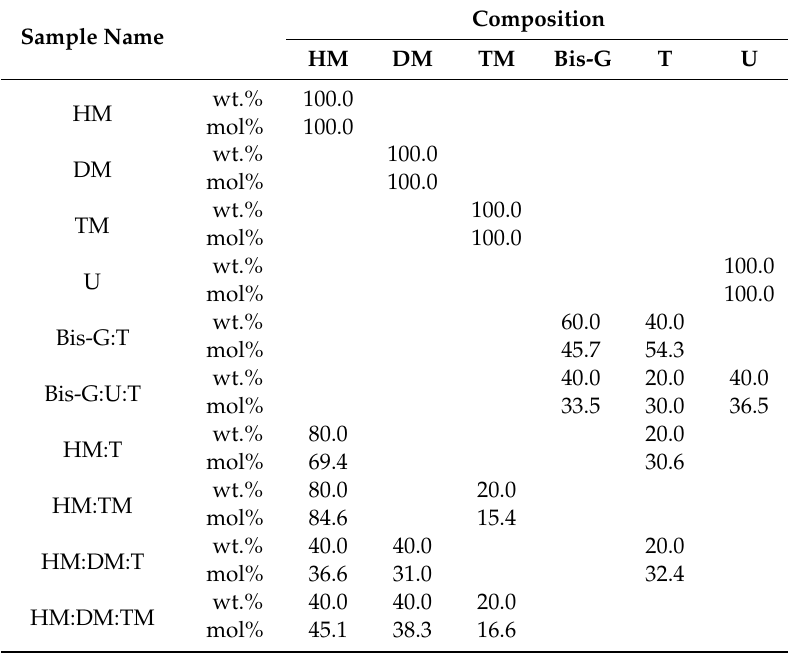
Table 1. The sample names and compositions. The product of the addition reaction of HEMA to MEBDI is abbreviated to HM, product of the addition reaction of DEGMMA to MEBDI is abbreviated to DM, product of the addition reaction of TEGMMA to MEBDI is abbreviated to TM, UDMA is abbreviated to U, Bis-GMA to Bis-G, and TEGDMA to